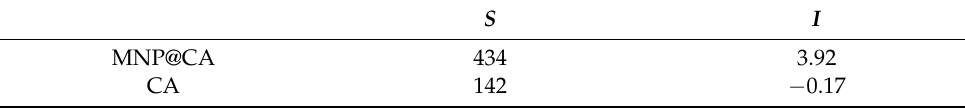
Table 4. The fitting parameters of the non-ideality analysis Fe 3 O 4